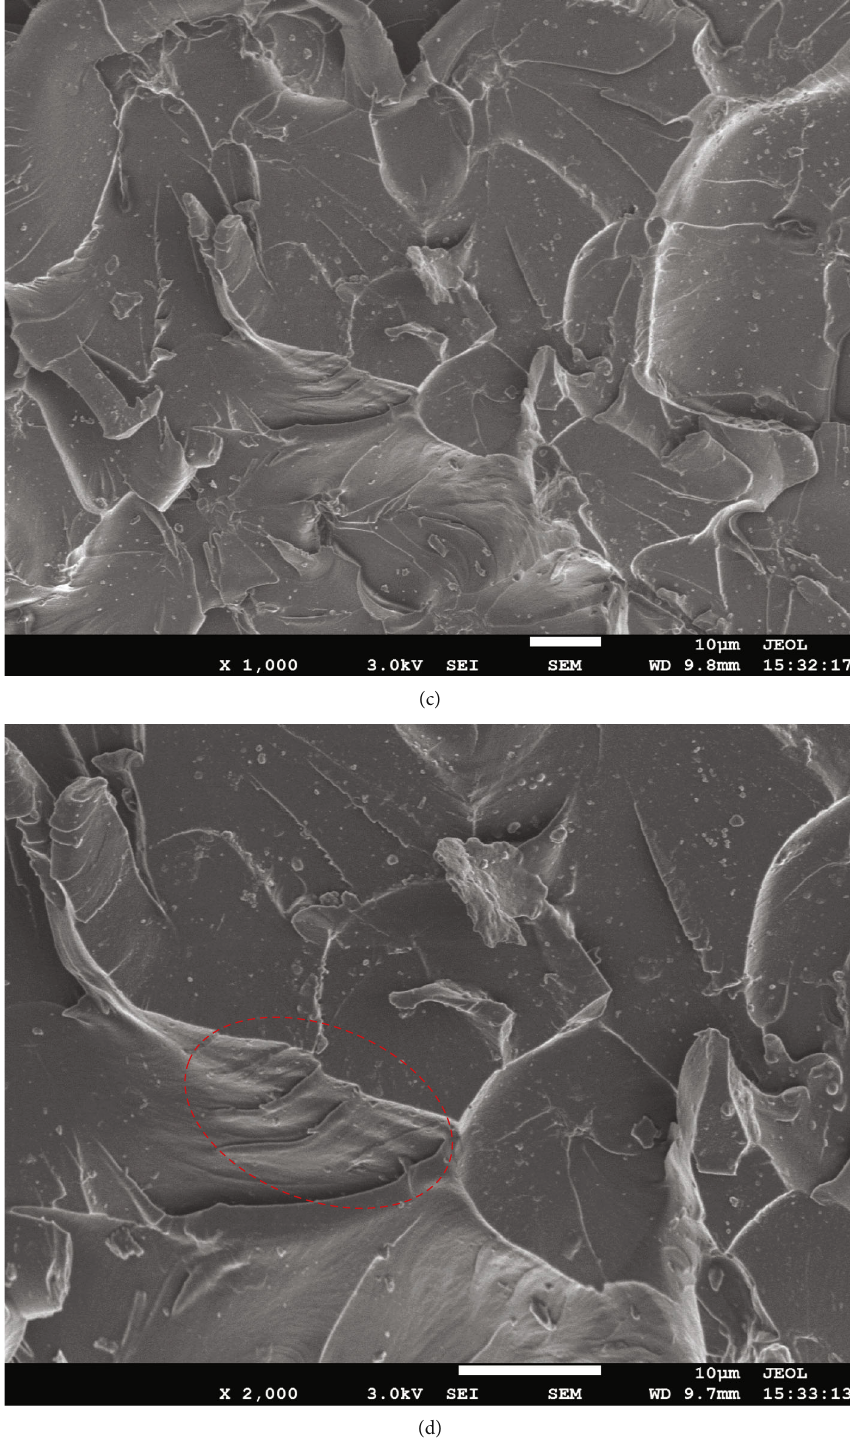
Figure 10: SEM images (a): pure epoxy resin specimen; (b): 0.05 wt.% GO-epoxy resin specimen; (c, d): 0.1wt.% GO-epoxy resin